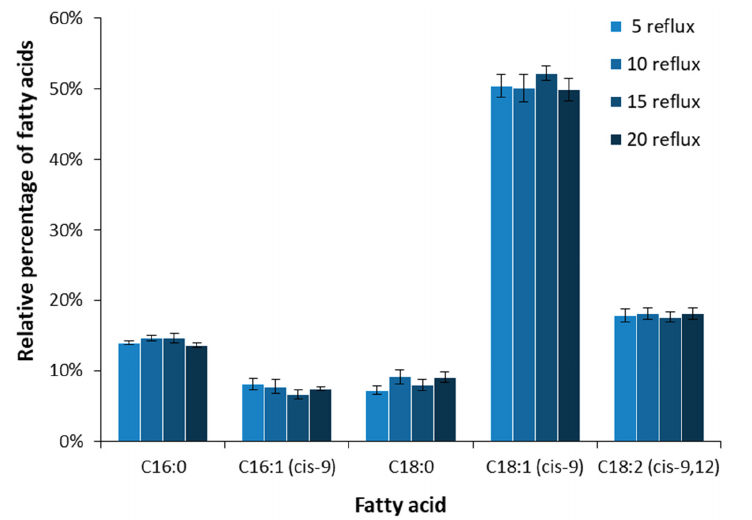
Figure 8. Fatty acid composition in relation to increasing reflux cycles of Soxhlet lipid extraction. Soxhlet extraction was conducted using MeOH/Hex ratio equal to 3:5 and dry biomass/solvent equal to 40. Blue shades correspond to different number of reflux cycles. Error bars indicate standard deviation. Number of replicates N = 3.